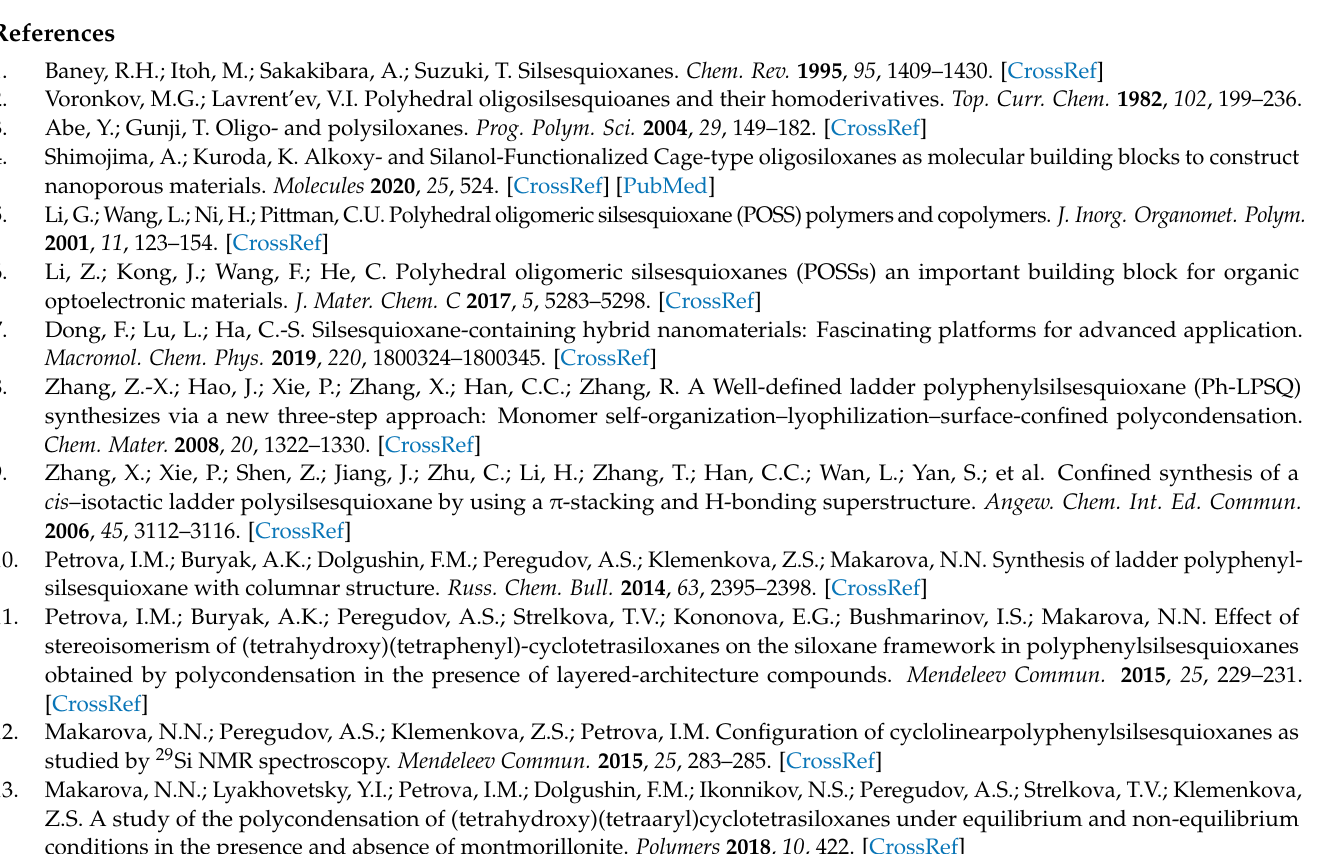
110 ◦ C for 45 min. Figure S3: PI-APCI mass spectrum of the precipitate from the reaction mixture of self-condensation of compound 2 carried out in a molybdenum glass flask in toluene solution at 110 ◦ C for 120 min. Figure S4: PI APCI mass spectrum of a mixture of compounds precipitated from the reaction mixture after the condensation of species 2 was carried out in anisole in a molybdenum glass flask at 130 ◦ C for 15 min. Figure S5: PI APCI mass spectrum of the precipitate from the reaction mixture of the compound 3 condensation conducted in a quartz flask in toluene at 110 ◦ C for 10 min. Figure S6: PI APCI mass spectra of samples of the precipitates from the reaction mixture of compound 4 condensation conducted in acetonitrile in a quartz flask at 75 ◦ C: (a) taken after 120 min and (b) taken after 240